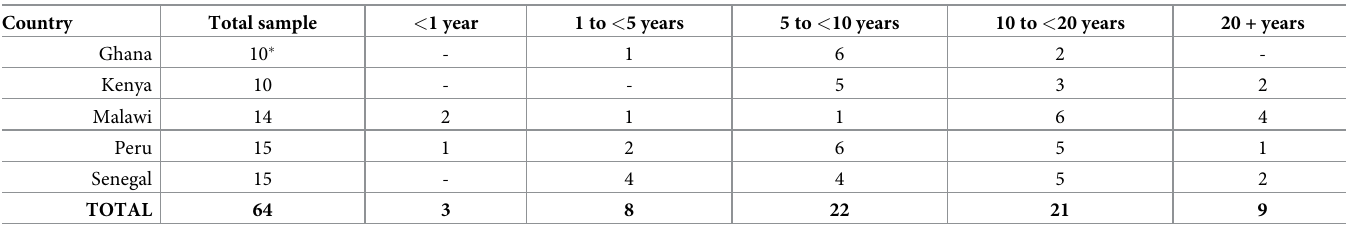
Table 4. Healthcare providers by country and years of experience in vaccine administration.